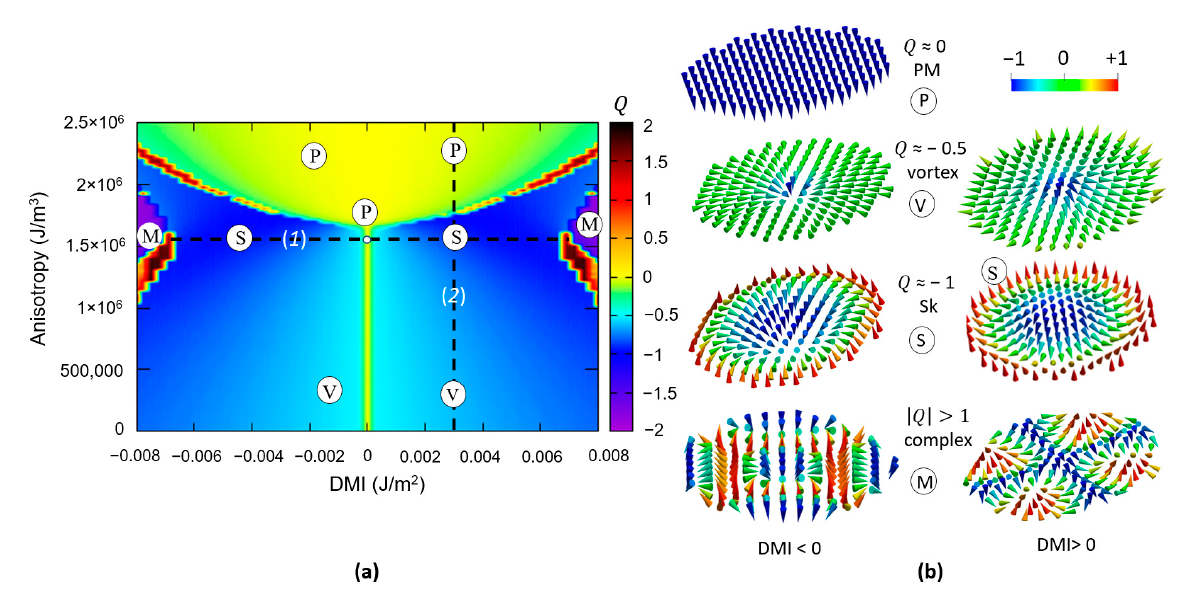
Figure 13. ( a ) Ground state diagram DMI-PMA-Q (90 nm circular disk) in which the micromagnetic states are classified after their topological charge Q . ( b ) Micromagnetic configuration in vector field glyph representation corresponding to chosen zones from the phase diagram: (P) = perpendicularly magnetized (PM) states, (V) = magnetic vortex states ( Q ≈ − 0.5), (S) = magnetic skyrmionic states ( Q ≈ − 1), (M) = complex chiral magnetic states with | Q | >1 for different vorticity chiral structures, determined by the sign of the DMI.